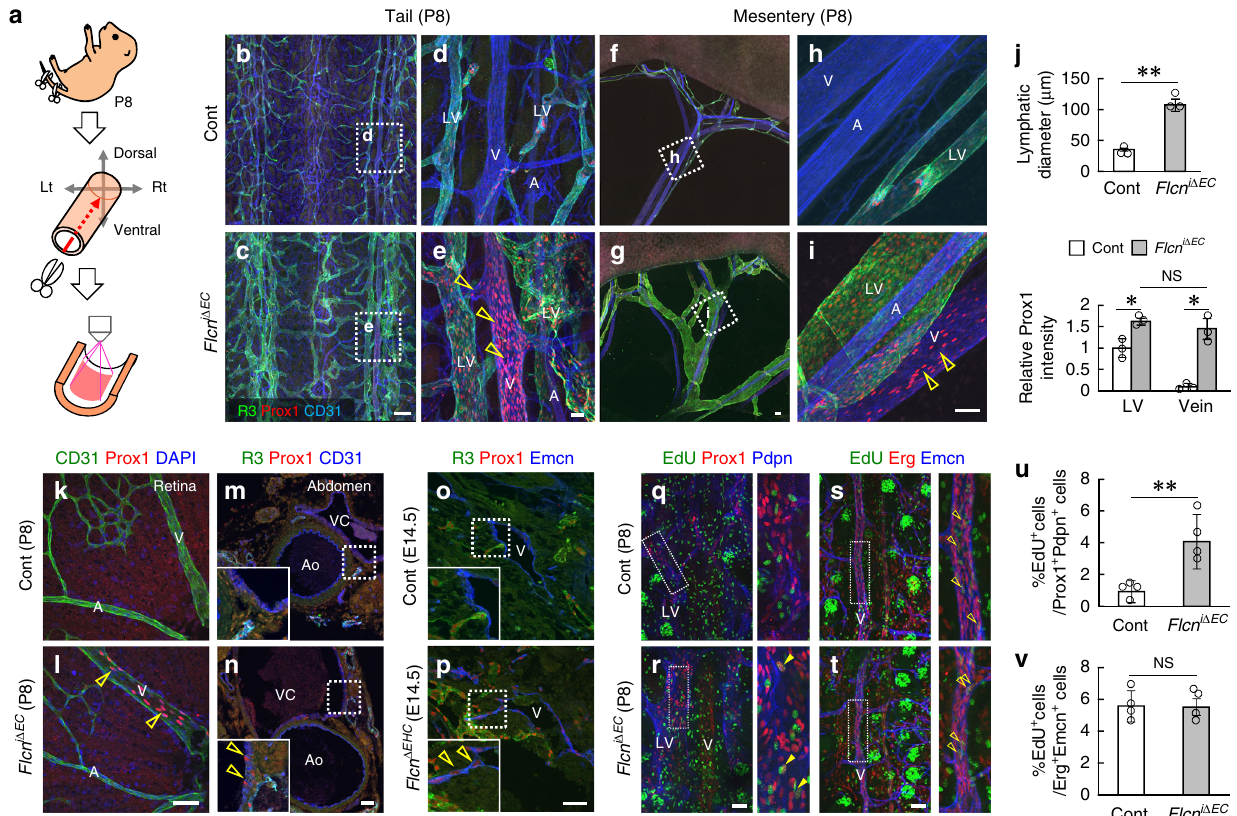
Fig. 2 Flcn de fi ciency leads to ectopic Prox1 expression in veins. a Schematic diagram depicting the technique used to prepare whole-mount tail samples. b – j Tail or mesenteric whole-mount samples at P8, and quanti fi cation in tails ( n = 3). Flcn i Δ EC mice show ectopic Prox1 expression (open arrowheads) in veins (V) and its branches. LV, lymphatic vessels; A, arteries. k – p Retinal whole-mounts or abdominal sections at P8 and embryonic sections at E14.5. Flcn i Δ EC and Flcn Δ EHC mice show ectopic Prox1 expression (open arrowheads) in veins (V) but not arteries (A). VC vena cava, Ao abdominal aorta. q – v Immunohistochemical analysis of tail whole-mounts at P8 and quanti fi cation ( n = 4). LVs show increased endothelial proliferation (closed arrowhead) in Flcn i Δ EC mice. Open arrowheads indicate proliferation in venous endothelial cells. Scale bars: 200 µ m ( b, c, f, g ); 50 µ m ( d, e, h, i, k – t ). ** P < 0.01; * P < 0.05; NS not signi fi cant, ND not detected. Data are presented as the mean ± SD. The comparisons between the averages of the two groups